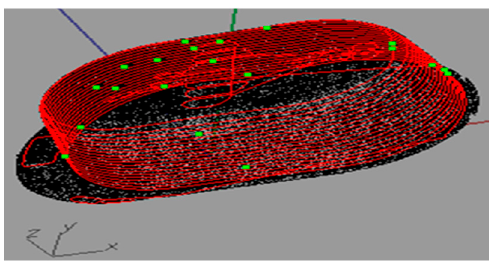
Figure 8. Point cloud slice along the Z-axis.